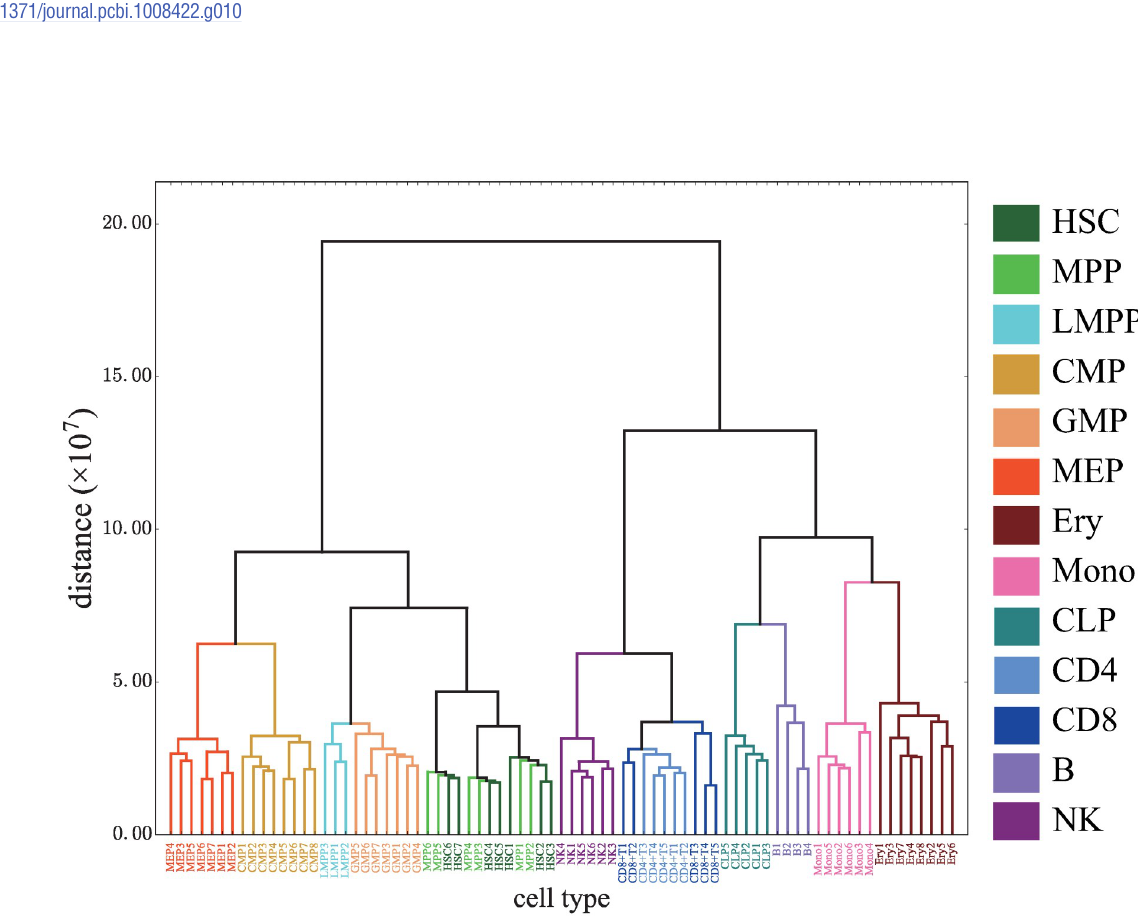
Fig 10. Penalty with cutoff of reads. The distribution of global penalty λ (A) and type penalty λ by Ward’s method.